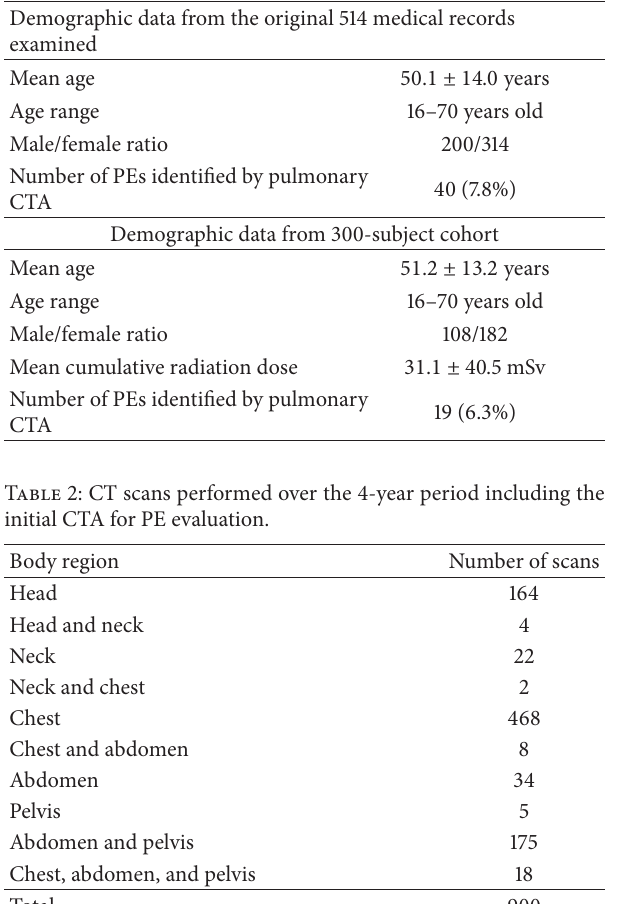
Table 1: Demographics of subjects.